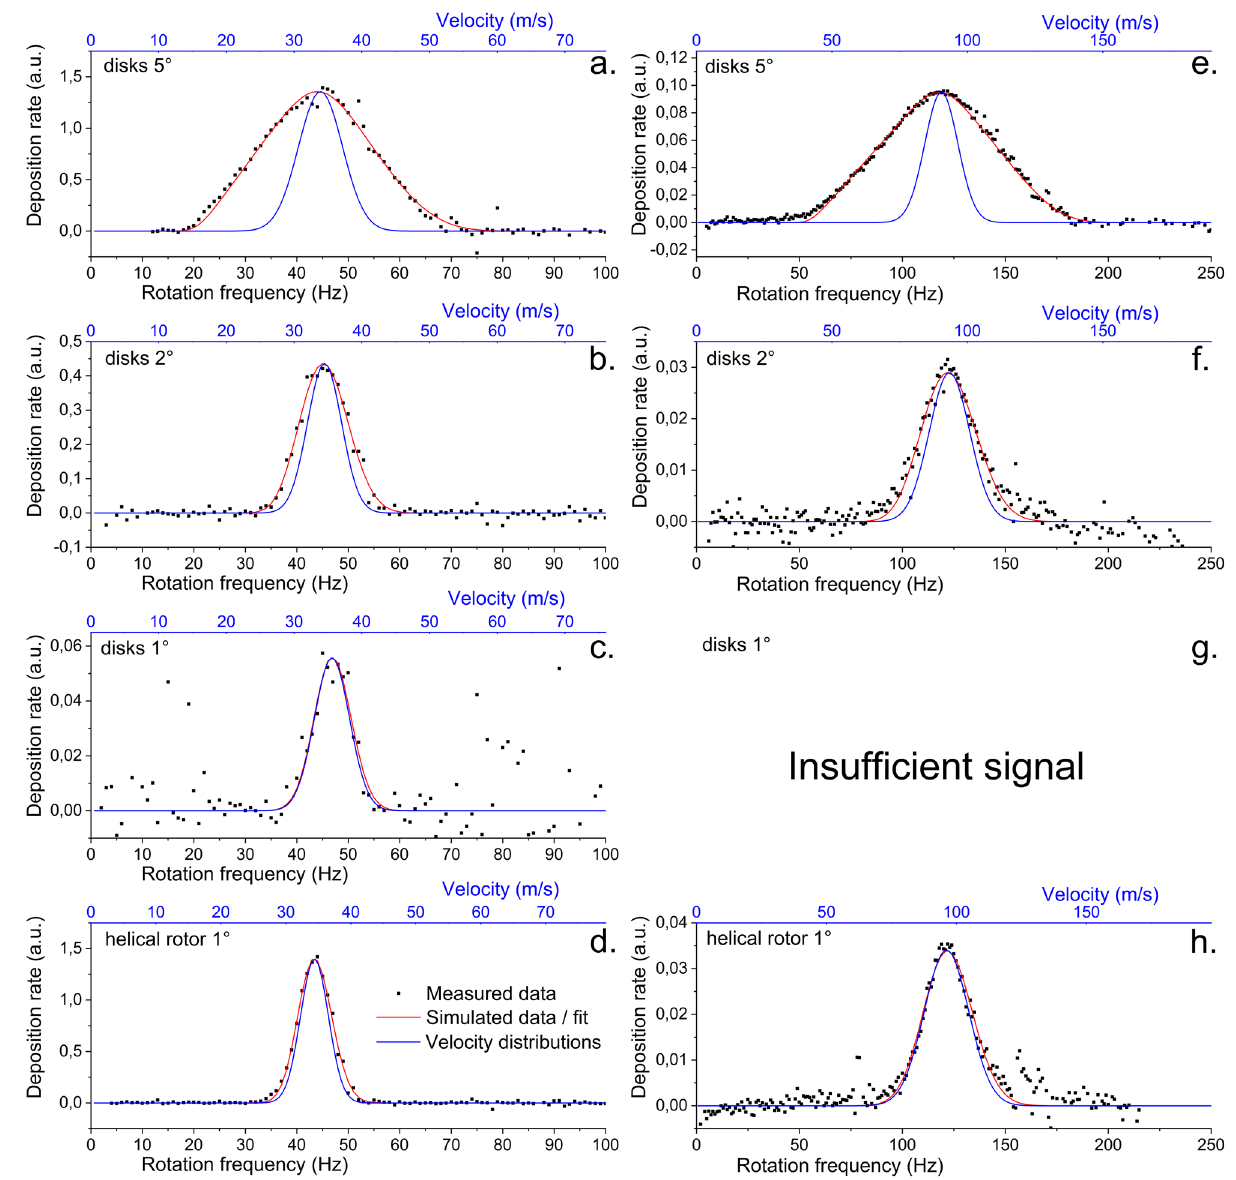
Figure 7. Comparison of the model with real measured data. ( a – d ) nanoparticles deposited at aggregation chamber pressure 20 Pa, deposition chamber pressure 0.015 Pa, DC magnetron current 200 mA and QCM averaging over 5 values; ( e – h ) nanoparticles deposited at aggregation chamber pressure 100 Pa, deposition chamber pressure 0.15 Pa, DC magnetron current 200 mA and QCM averaging over 20 values. The relative angle of the inlet and exit slit was 9°, disk distance 19 mm, disk thickness 1 mm, thickness of helical rotor was 20 mm printed with layer thickness 0.2 mm and the angular width of the slits was ( a , e ) disks 5°; ( b , f ) disks 2°; ( c , g ) disks 1° and ( d , h ) helical rotor 1°. The lower black axis is the directly measured frequency of the rotor, the upper blue axis is formally converted to velocity using Eq. (15). The fits of the measured data in red are accompanied by the derived NPs velocity distributions in